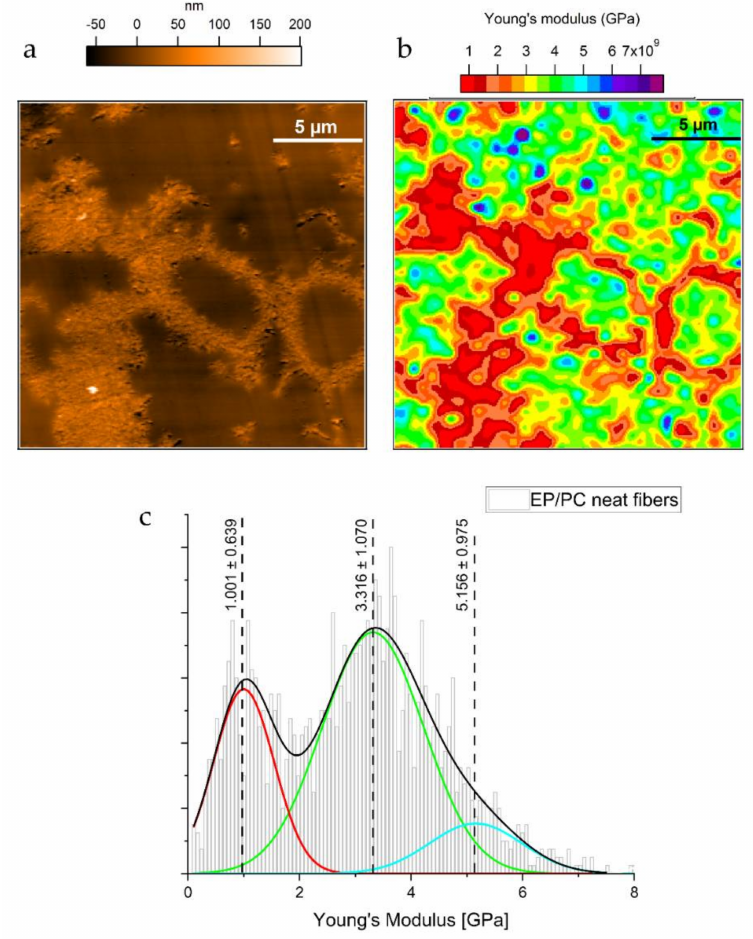
Figure 3. ( a ) AFM Topography map of an area of the composite showing presumably several neat PC fibers; ( b ) Young’s Modulus map of the area shown in ( a ); ( c ) Young’s modulus distribution from the scanned area. The maps were taking from the bulk sample after extracting the ultra-microtomed slices (the Young’s modulus map with 80 × 80 data points is interpolated to match the pixel number of the corresponding topography image, which is 512 × 512 data points). In the deconvoluted signal: red indicates the PC phase, green and light blue correspond to EP